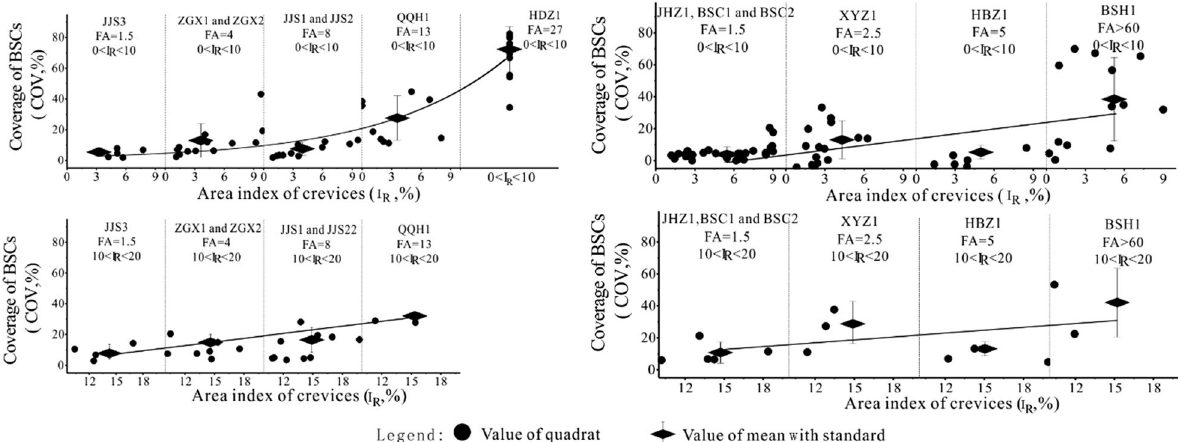
Fig. 9 Relationship of COV with small I R on rock cut slopes at sampling sites. FA and I R in the figure represent the formation age and crevice density of RCSs,